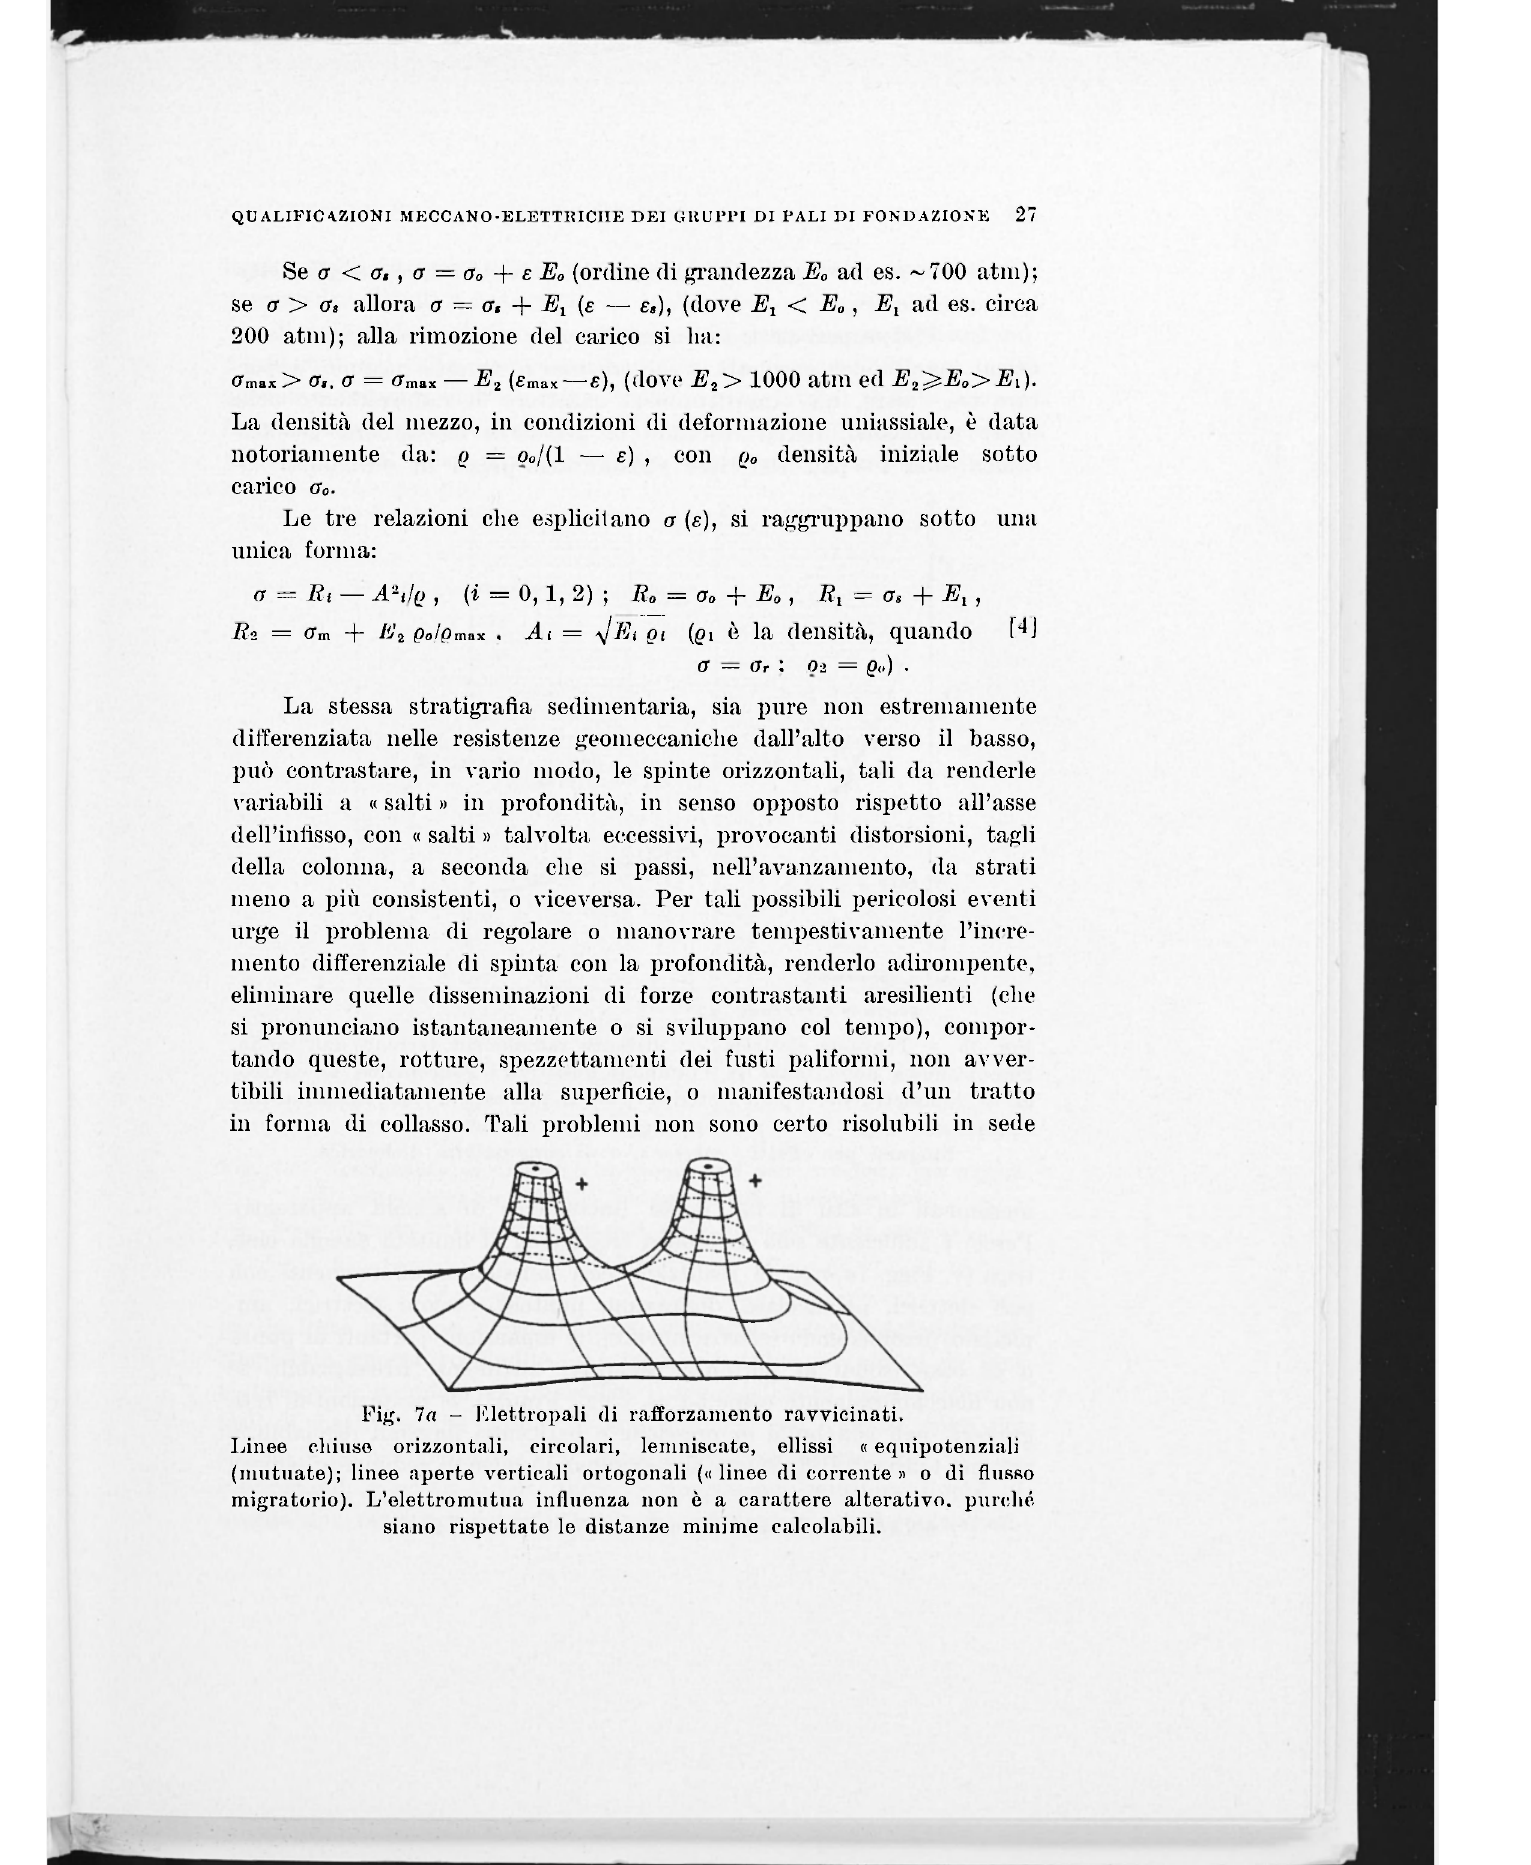
Fig. la - Elettropali (li rafforzamento